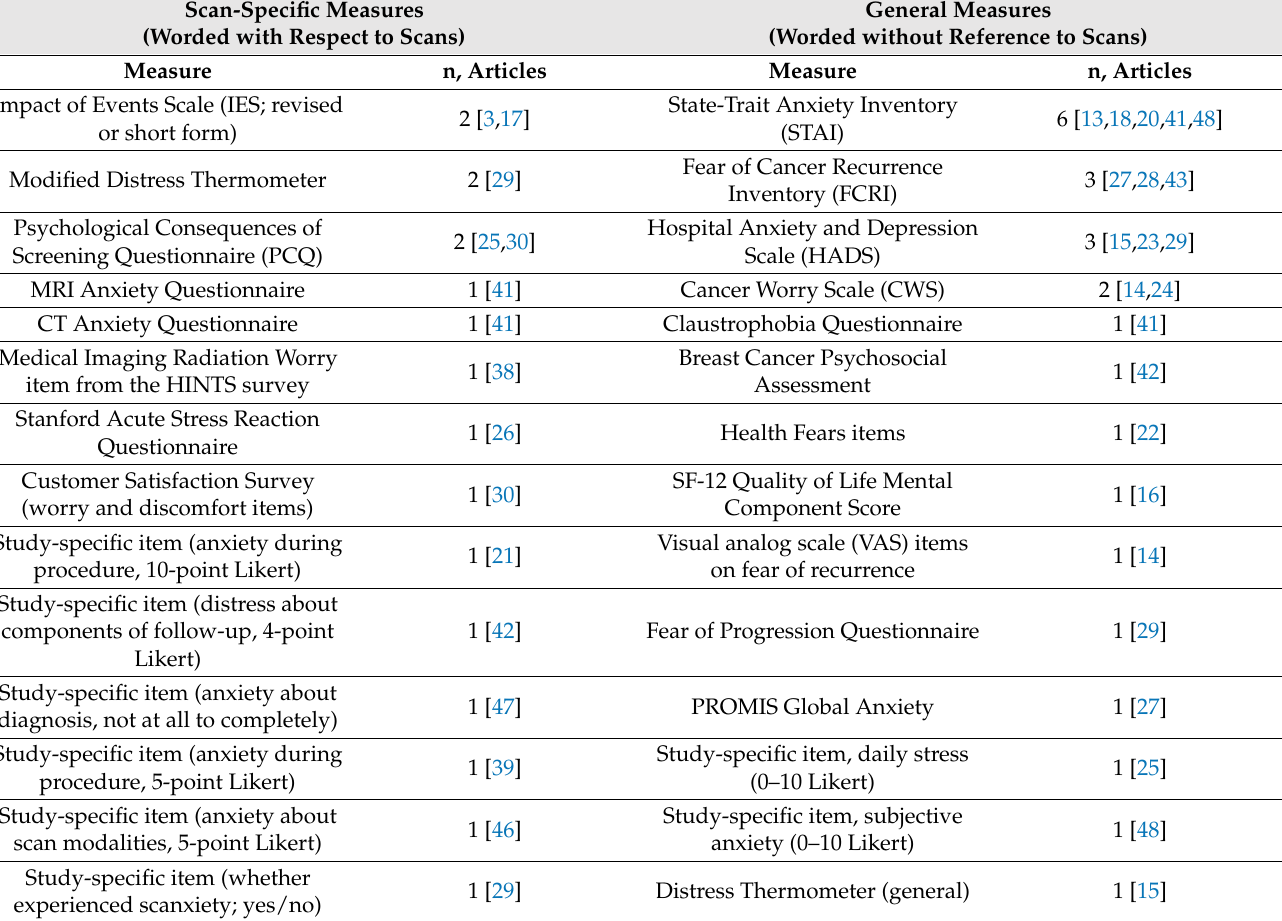
Table 4. Quantitative measures of scanxiety used in included articles, according to scan-specific vs. general